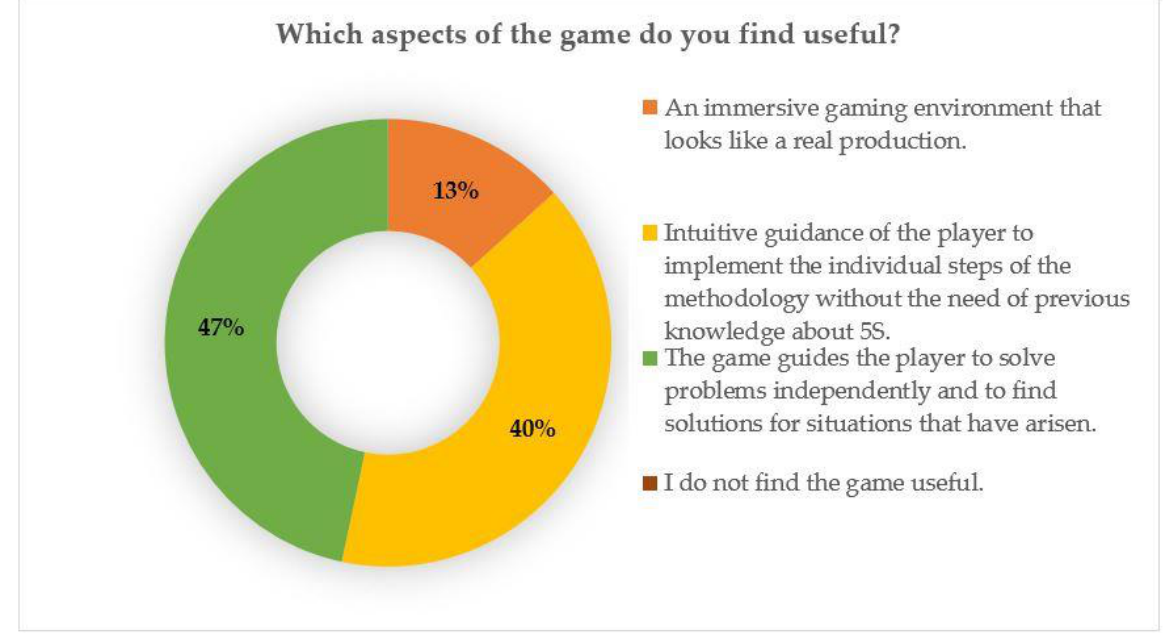
Figure 15. Subjective evaluation of aspects of educational game.